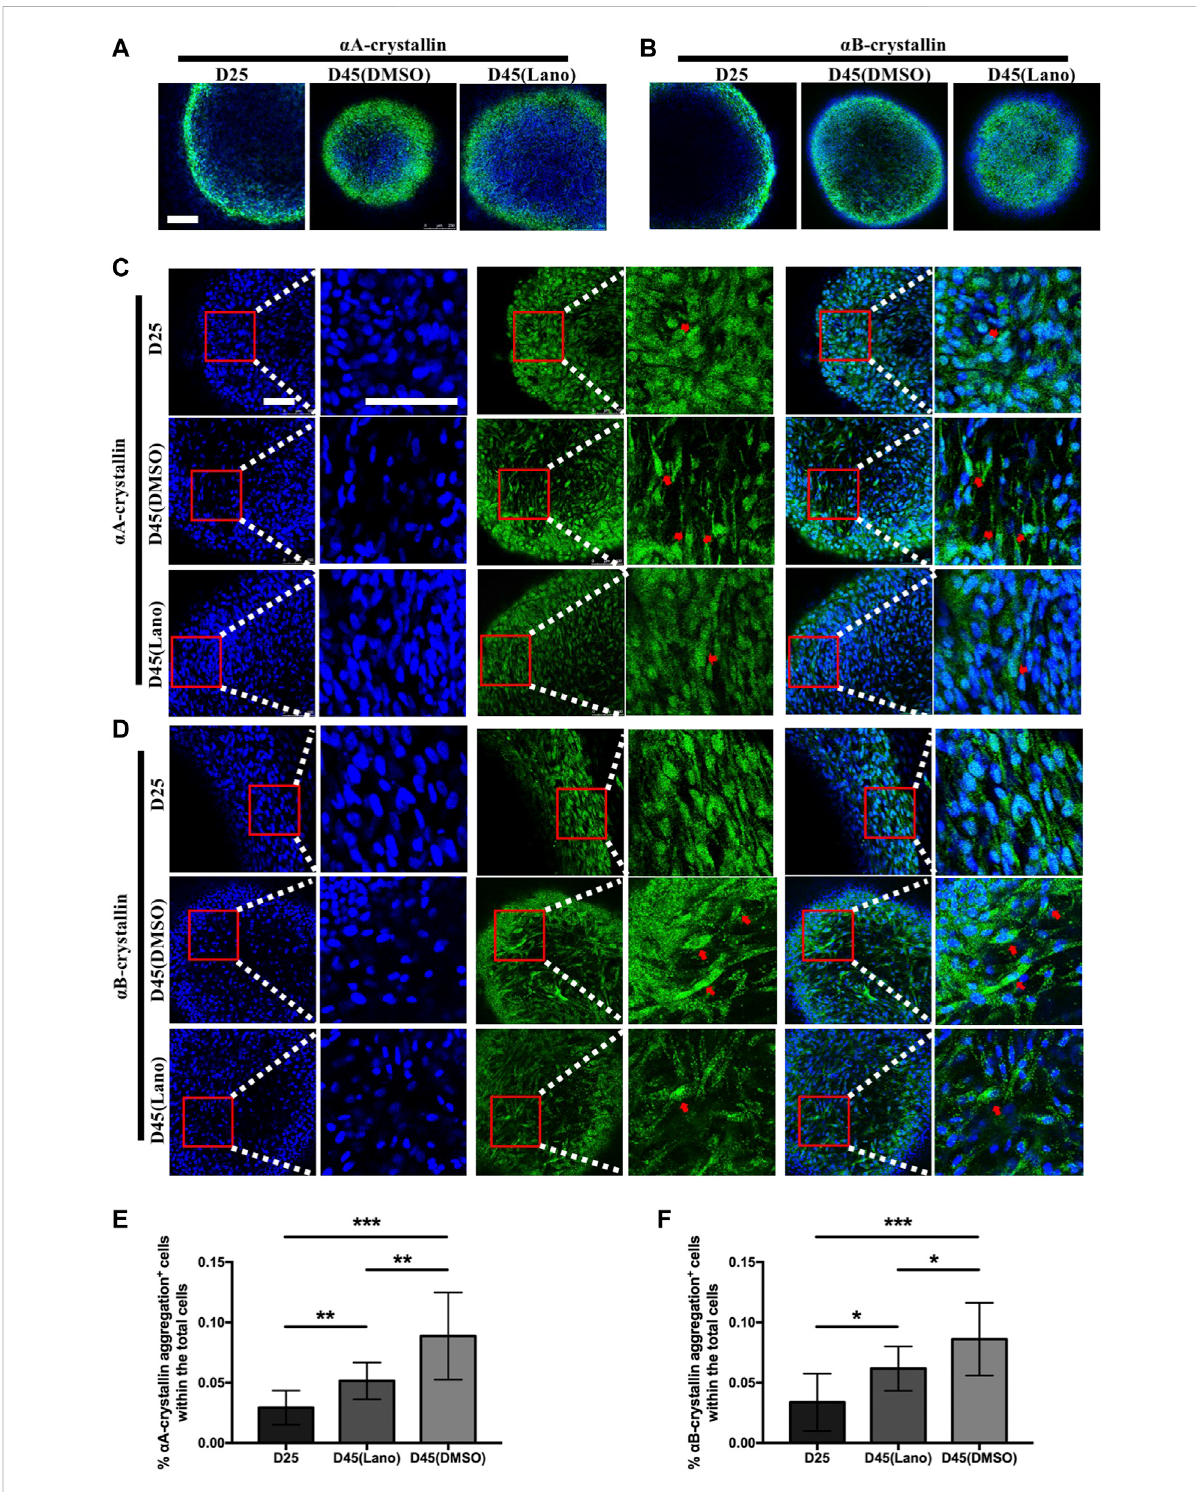
FIGURE 4 Protein aggregation in control and lanosterol treated LBs. (A,B) Immuno fl uorescence examination showed the expression of α A-crystallin and α B-crystallin in LBs on D25 and D45. (C,D) Cells containing α A-crystallin or α B-crystallin protein aggregations (red arrows) were highly abundant in control cloudy LBs on D45 compared with lanosterol treated LBs on D45. (E,F) Quanti fi cation data showed that more cells containing protein aggregationswereobservedincontrolcloudyLBsonD45comparedwithcontrolLBsonD25andlanosteroltreatedLBsonD45.Barsrepresent mean ± SD. * p < .05, ** p < .01, *** p < .001. Bar: 250um (A,B) , 100um (C,D) . DMSO, dimethyl sulfoxide. Lano,